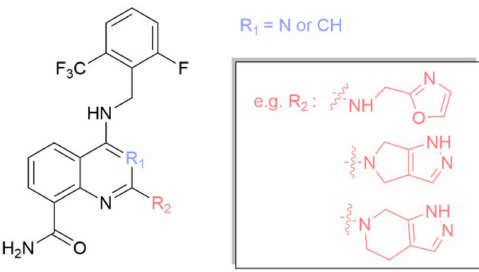
Figure 5. The main sca ff old, and example R-groups, of the compounds screened by Deaton et al